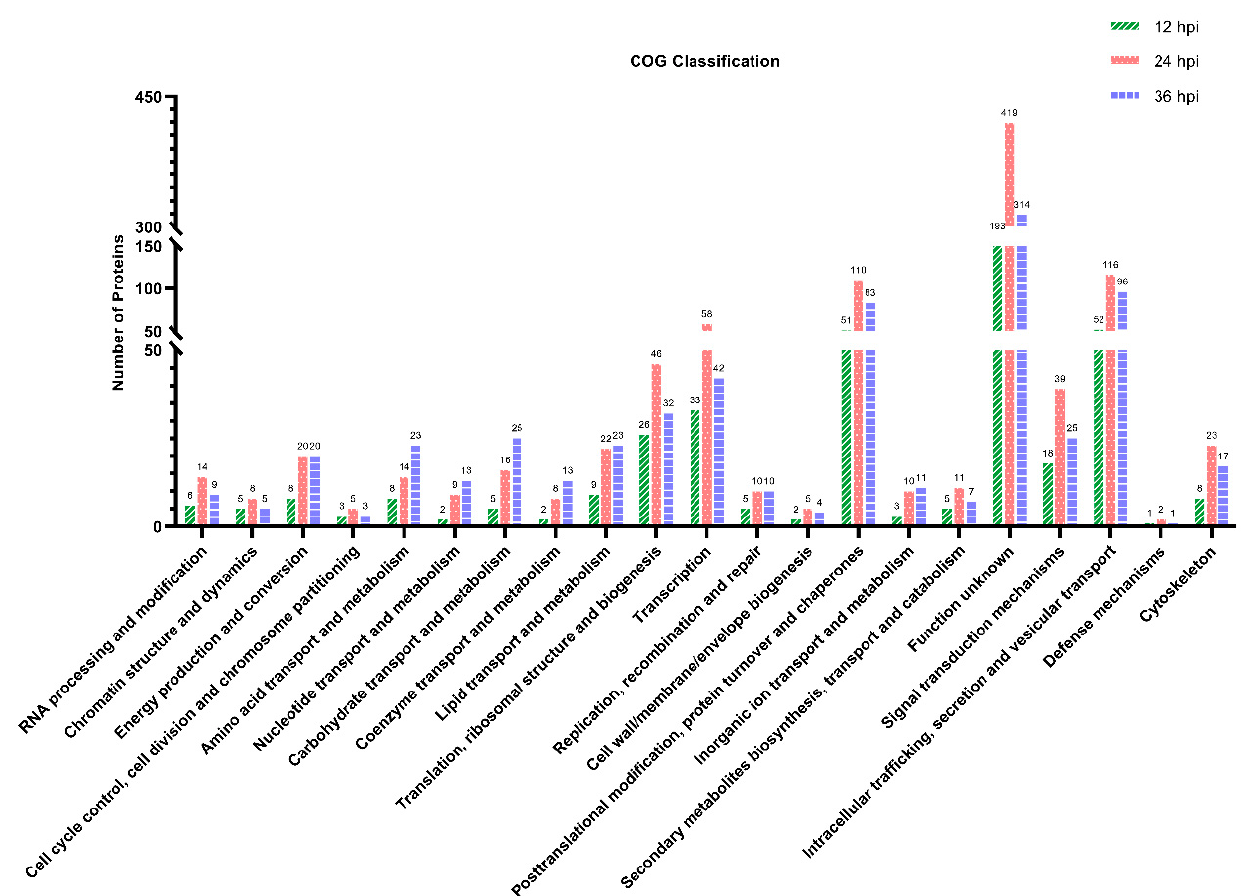
Figure 4. Clusters of Orthologous Groups (COG) function classification of the DEPs identified in PK-15 cells during SVA infection. A total of 445, 965 and 776 DEPs identified at 12, 24 and 36 hpi, respectively, were assigned to one or more of the 21 COG categories. The abscissa represents the COG categories and the ordinate indicates the number of DEPs in each category.